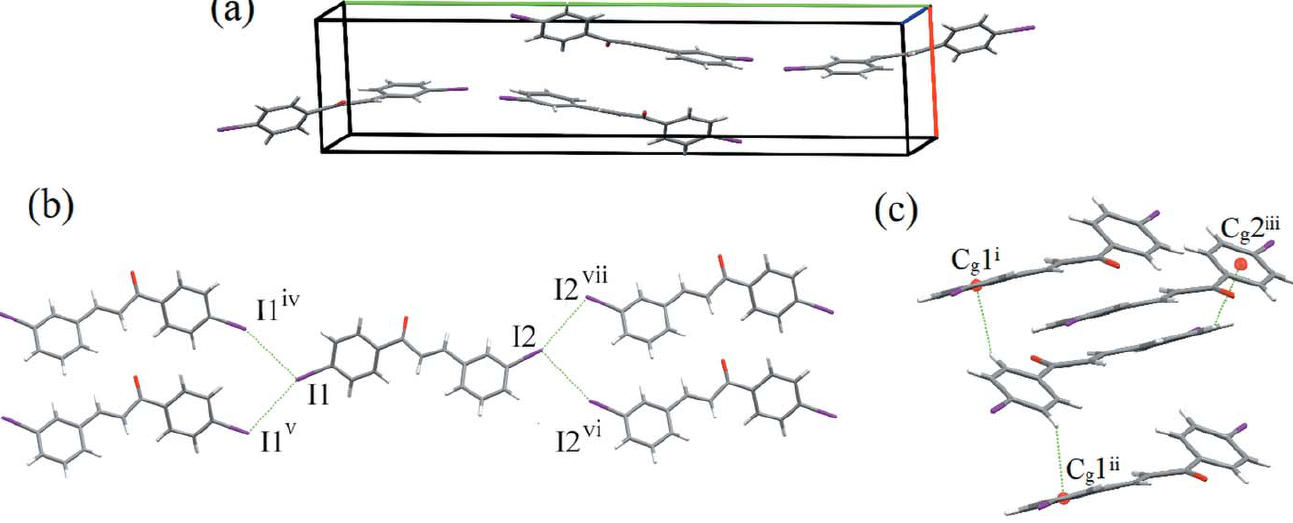
Figure 3 ( a ) A packing diagram of the title compound in the unit cell. Red, green and blue axes indicate a , b and c , respectively. ( b ) Meta – meta and para – para halogen bonds indicated by dashed lines. ( c ) Three weak C—H (cid:3)(cid:3)(cid:3) (cid:3) interactions (dashed lines; C5—H5 (cid:3)(cid:3)(cid:3) Cg 1 i , C8—H8 (cid:3)(cid:3)(cid:3) Cg 1 ii and C14—H14 (cid:3)(cid:3)(cid:3) Cg 2 iii ).